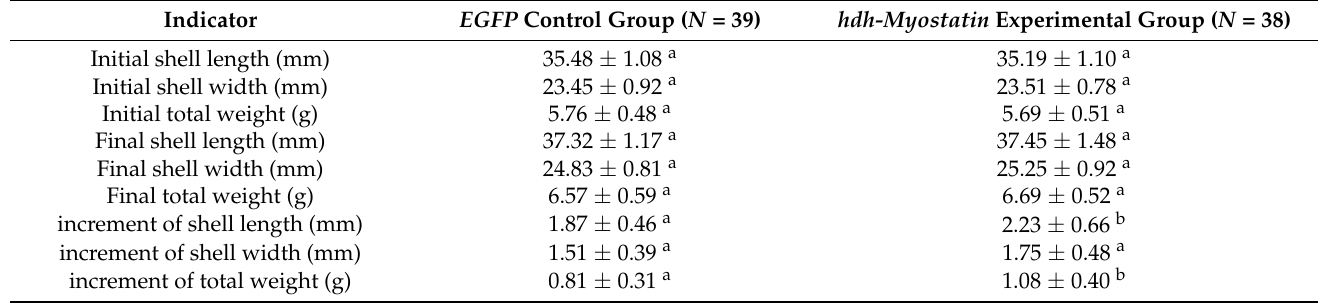
Note: Mean values with different letters within a column are significantly different ( p < 0.05).